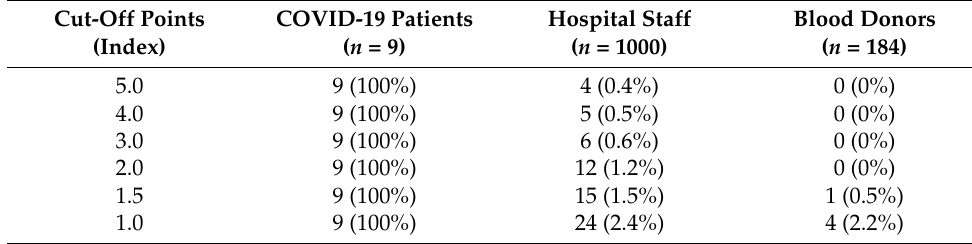
Figure 4. Radioligand assay (RLA) results. Results obtained from all 13 assays were collated, including those from the hospital staff ( n = 1000) and blood donors ( n = 186). COV3, 4, and 7 were the positive controls. Table 1. Number of positive cases with various cut-off points.